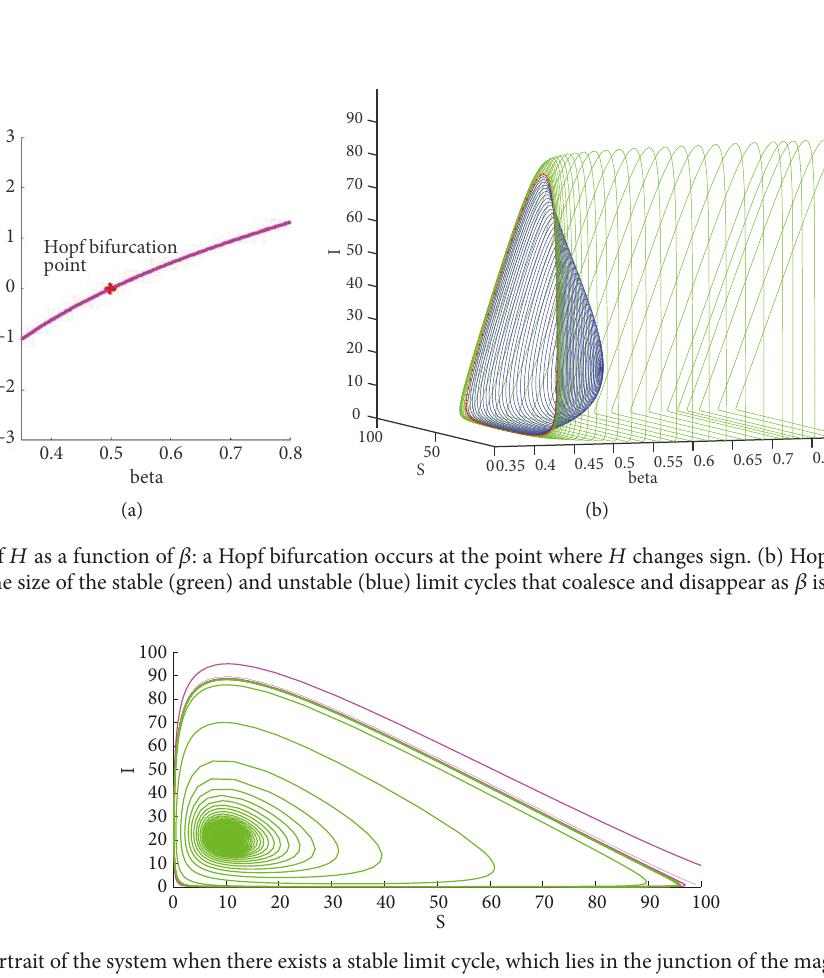
several values between 0.5 and 0.0916. We can see that the two BT points get closer to each other as 𝜀 decreases, and they coalesce and become a BT point of codimension 3 at the critical value (which is approximately 𝜀 = 0.0916 ), as stated vanishes, while the other coefficients become approximately